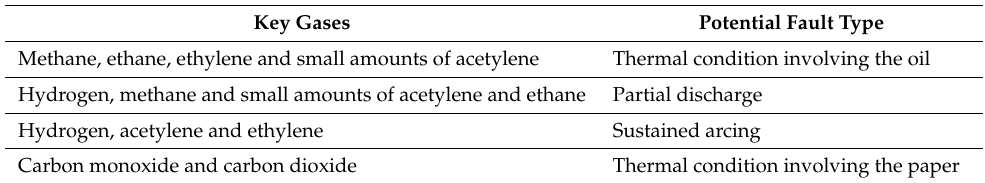
Table 2. Categories of key gases and general fault conditions